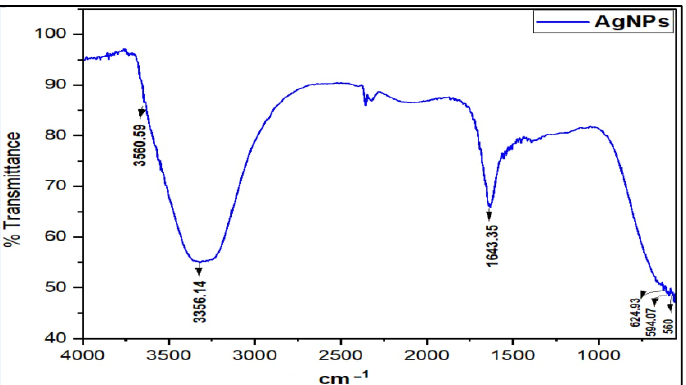
Figure 2. FT-IR absorption spectrum of AgNPs. The X-Ray Diffraction (XRD) patterns of characteristic sharp peaks for AgNPs were located at 2 θ at 38.117°, 44.279°, 64.428°, and 77.475°, and indexed to (111), (200), (220), and (311) planes, respectively, belonging to the face-centered cubic (FCC) crystalline struc- ture of the silver (JCPDS, file No. 04-0783) (Figure 3). The finding agreed with a previous study [30]. The average crystalline size was ~34.28 nm, which was calculated from Scher- rer’s Equation [31].